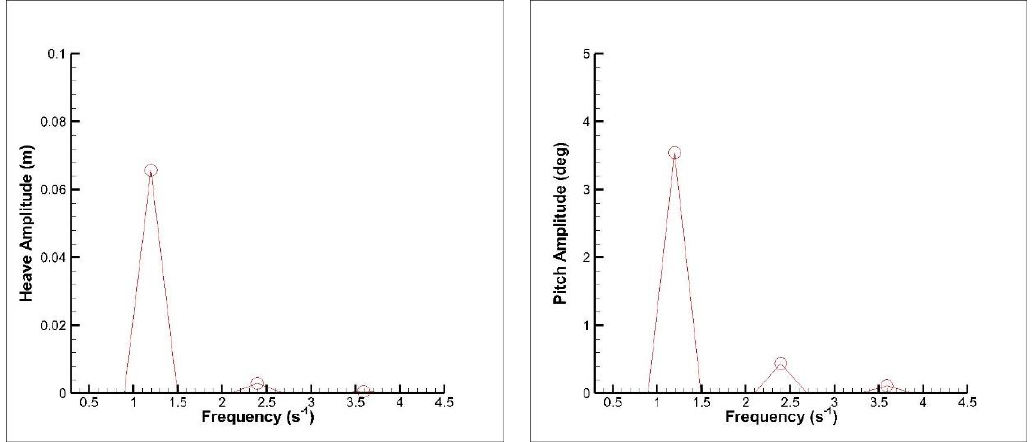
= 2.26, mono hull. B